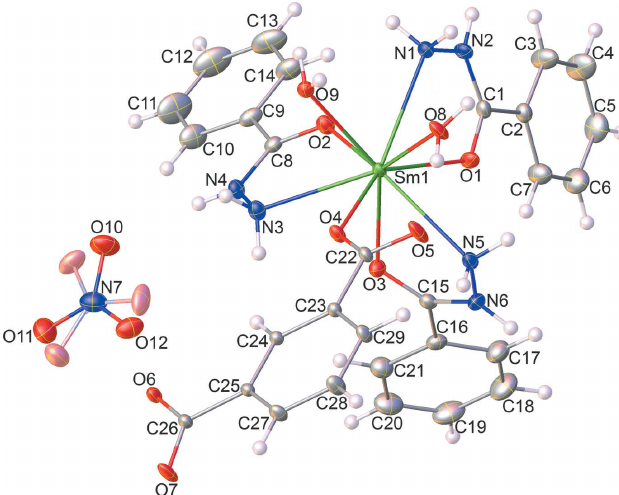
Figure 1 Molecular structure of the title compound, showing the atom-labelling scheme. Displacement ellipsoids are drawn at the 30% probability level.